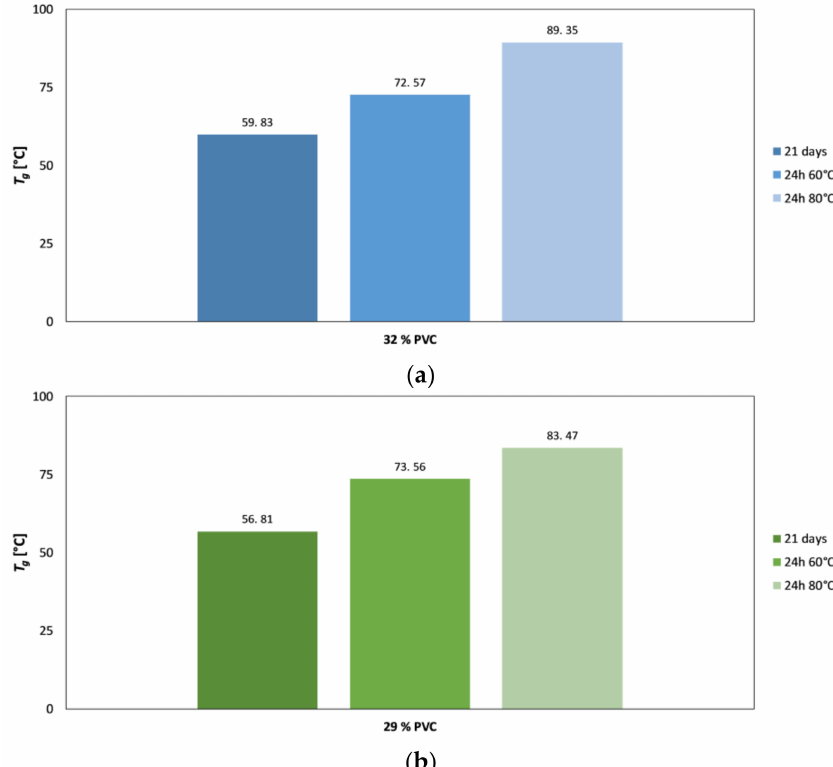
Figure 10. Glass transition temperature ( T g ) measured by DMTA of the representative samples 32% of PVC ( a ) and 29% of PVC ( b ) WB talc coatings. The left columns represent the present samples treated at room temperature. The middle columns represent the samples treated 24 h at 60 ◦ C. The right columns represent the samples treated 24 h at 80 ◦